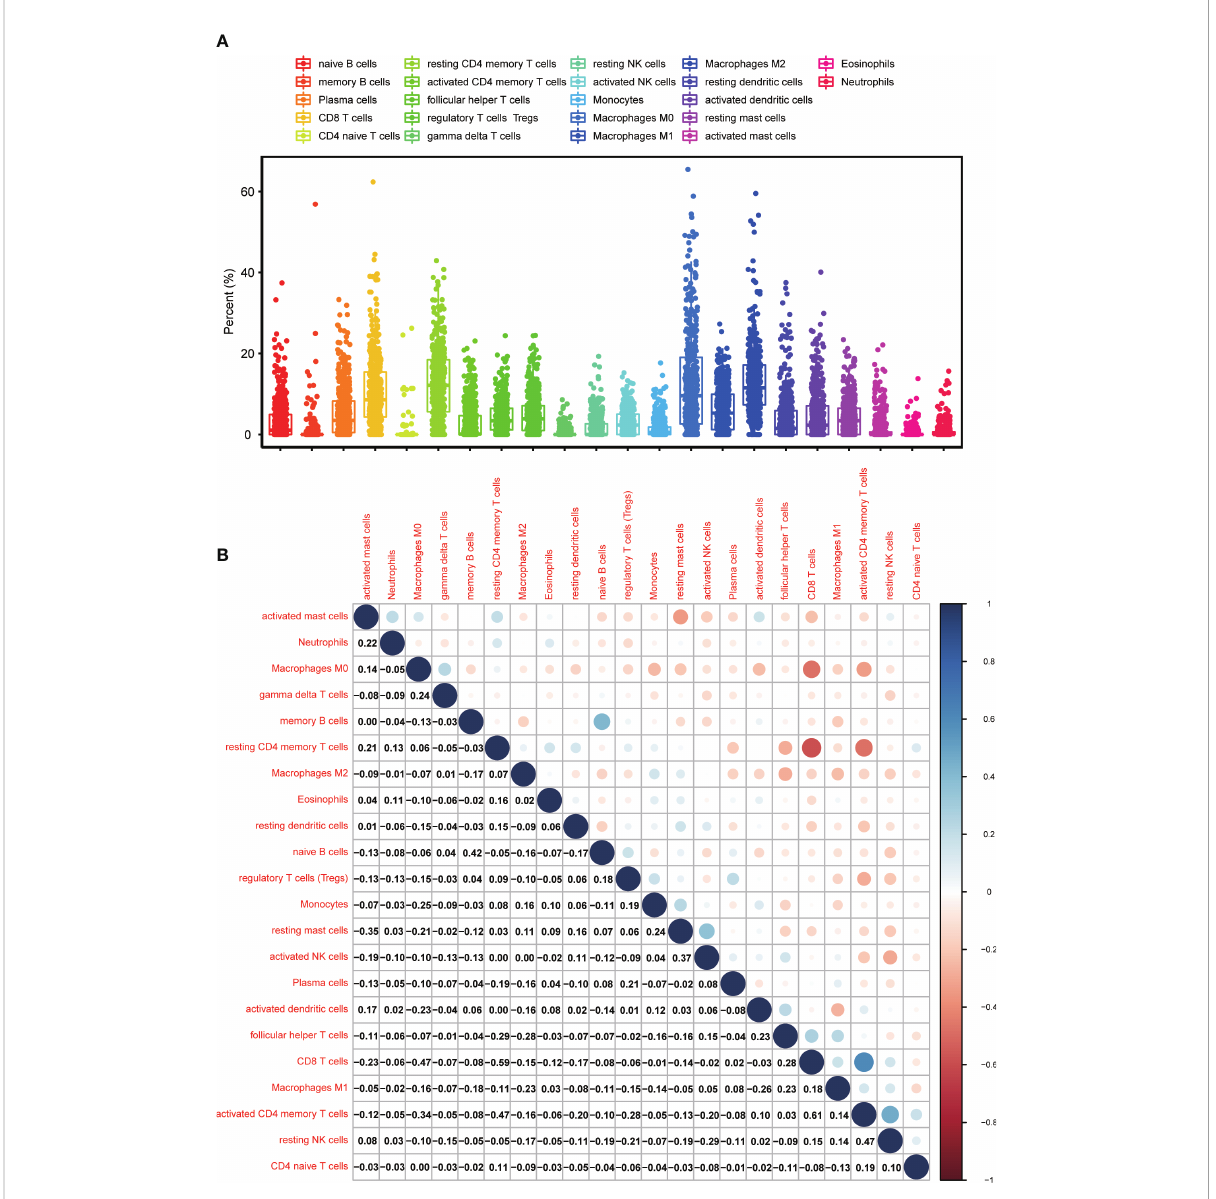
FIGURE 7 TICs Pro fi le, and the difference analysis as well as correlation analysis between CXCL12 and TICs in TIME of BLCA. (A) The ratio of TICs in BLCA samples; (B) The correlation analysis among TICs; each spot indicated p